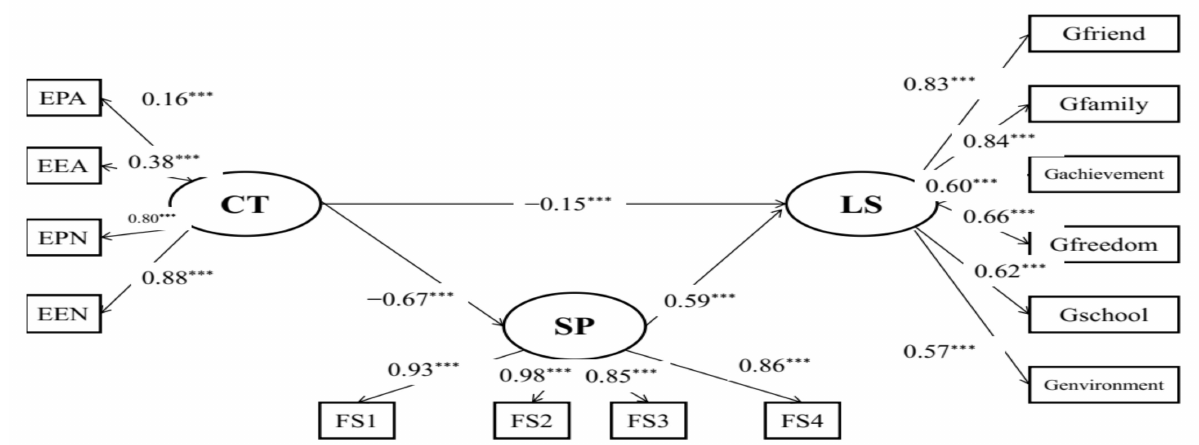
Figure 2. Mediation model of child maltreatment, life satisfaction, and social support. EPA: physical abuse; EEA: emotional abuse; EPN: physical neglect; EEN: emotional neglect; FS1: social support 1; FS2: social support 2; FS3: social support 3; FS4: social support 4; CT: childhood maltreatment; LS: life satisfaction; RE: resilience; SP: social support; *** p <